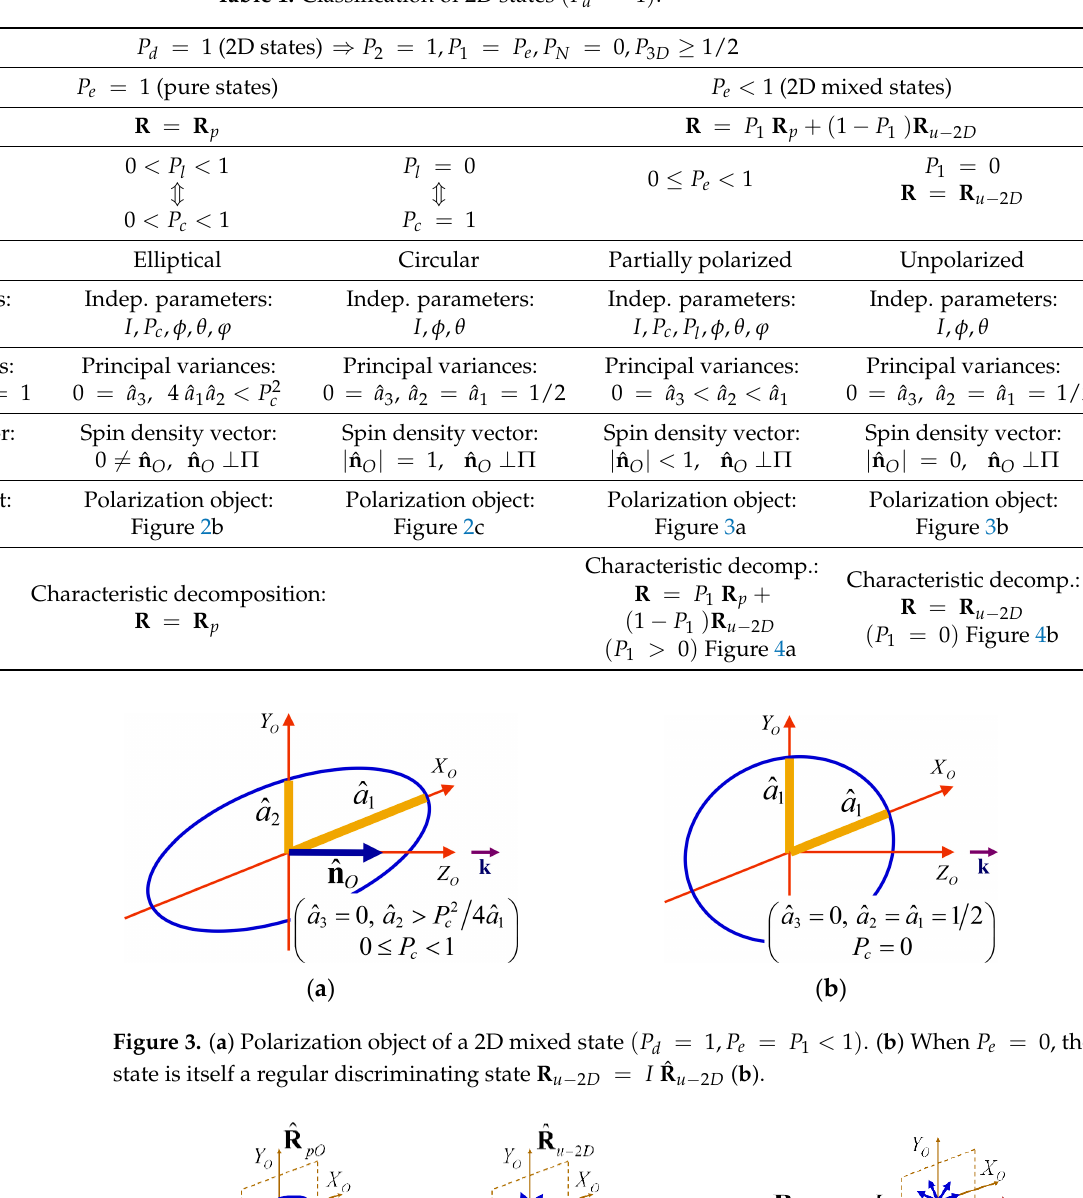
Table 1. Classification of 2D states ( P d = 1 ) .